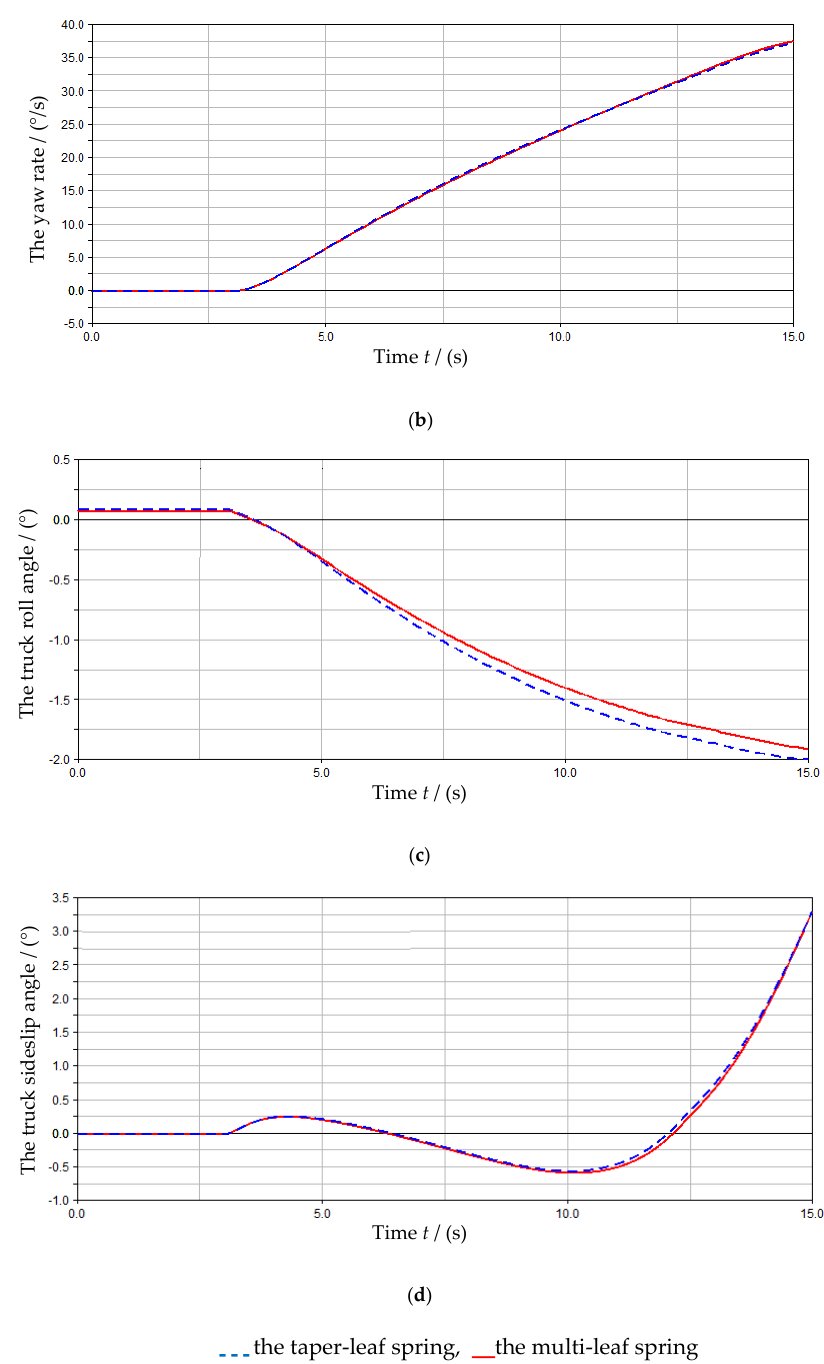
Figure 12. A comparison of the simulated dynamic responses obtained from the ramp steer tests: ( a ) The steering wheel torque, ( b ) the yaw rate, ( c ) the truck roll angle, and ( d ) the truck sideslip angle.